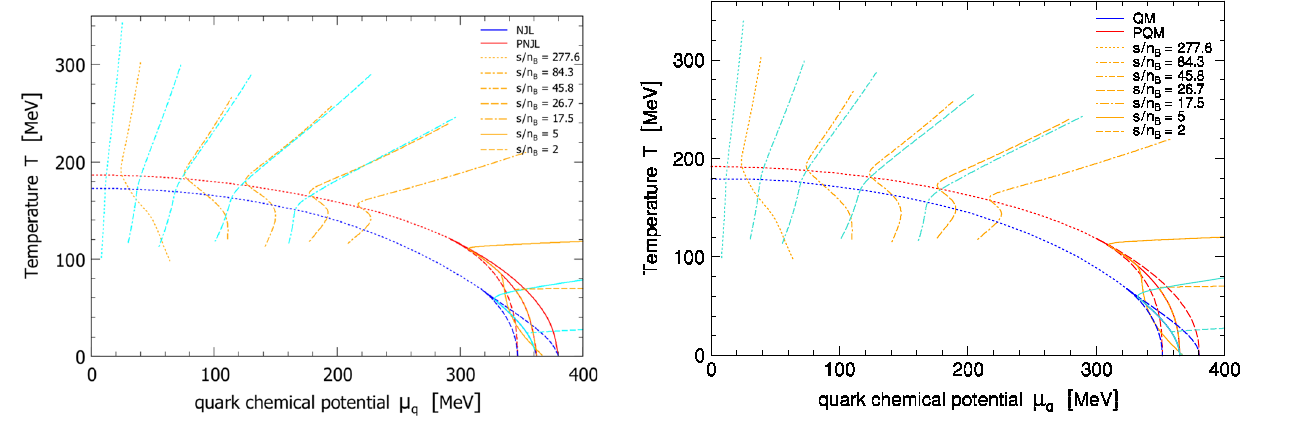
Maxwell construction. The stationary points of the isothermal curves lie on top of the spinodal lines: between them the system is unstable and cannot be found in a homogeneous